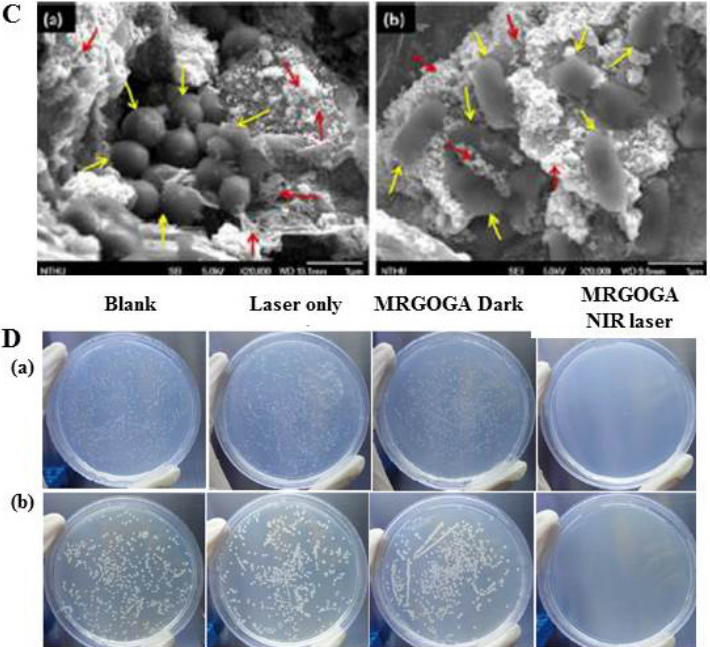
Figure 12. Efficient capture and targeted PTT of bacteria by MRGO, MRGOGA, and MCNGA. ( A ) The capturing capability of S. aureus ( a ) and E. coli ( b ). ( B ) The batch mode and dynamic mode (lab on chip) PTT with laser irradiated at 808 nm. ( C ) SEM of E. coli ( a ) and S. aureus ( b ) after capturing by MRGOGA. ( D ) Bacterial plates for both S. aureus ( a ) and E. coli ( b ), blank, laser only, MRGOGA dark, and MRGOGA with NIR laser). Reprinted/adapted with permission from Ref. [150]. Copy right 2013, copyright ACS 2013.